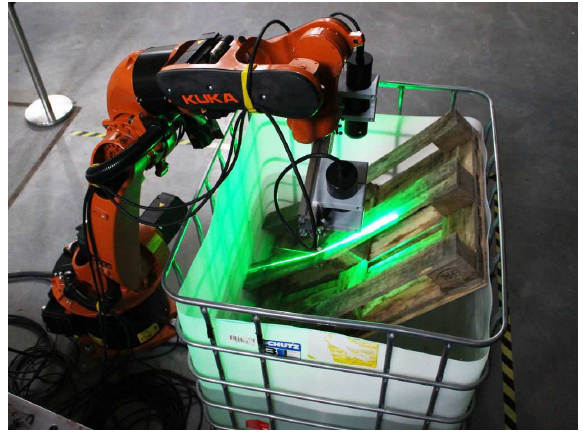
Figure 1. Prototype underwater line laser scanner mounted on an industrial manipulator for scanning a semi-submerged